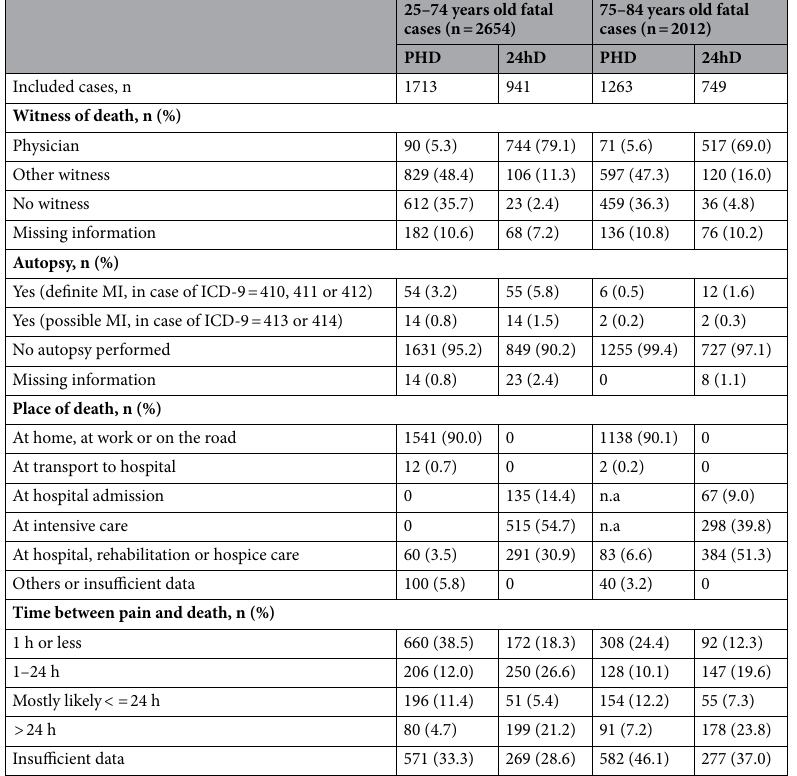
Table 2. Additional characteristics of the fatal cases (n = 4666). PHD pre-hospital deaths, 24hD deaths within the first 24 h after hospitalization, MI myocardial infarction, ICD-9 International Classification of Diseases, 9th